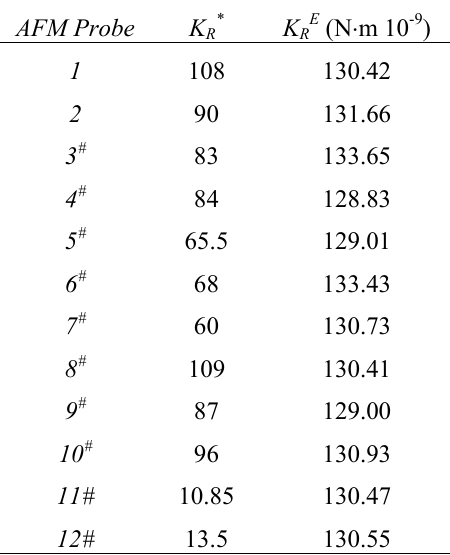
Table 4. A comparison of the rotational stiffness K R* and effective E values for the 12 AFM cantilevers rotational stiffness K R